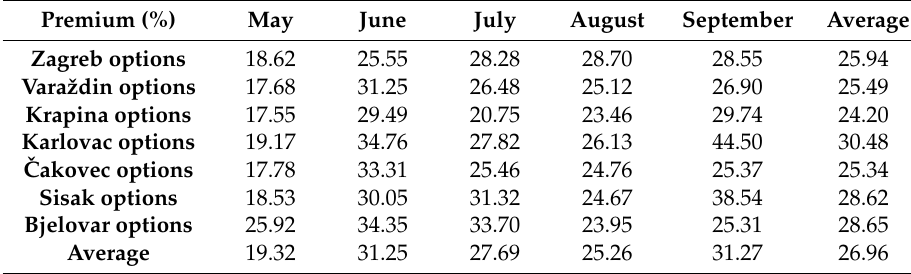
Table 5. Cost of premium relative to maximum weather derivative